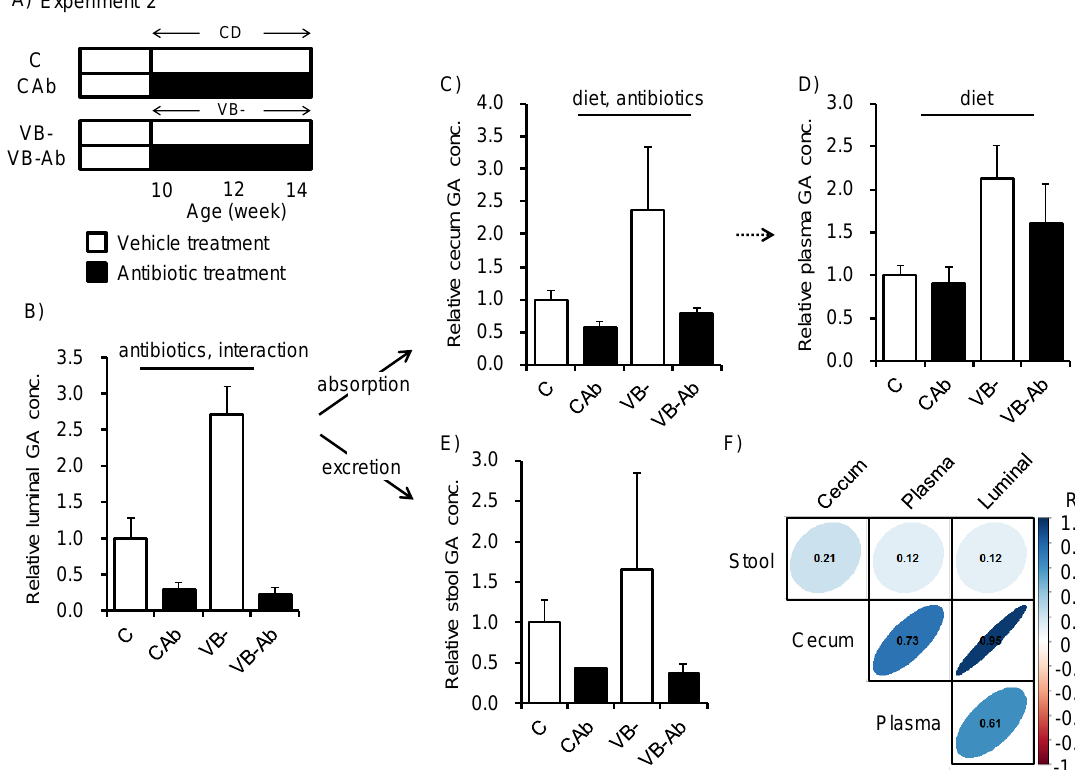
Figure 2. Both the gut microbiota and host accumulated glycolate in mice fed the VB- diet. ( A ) Study design for Experiment 2. Mice were fed the control diet or VB- diet for 4 weeks with or without treatment with four different antibiotics (150 mg/mouse/day penicillin V, ampicillin, metronidazole, and 75 mg/mouse/day vancomycin solved in distilled water). ( B – E ) Relative concentration of GA in ( B ) luminal content, ( C ) cecum, ( D ) plasma, and ( E ) stool among the four groups ( n = 3–4). Two-way ANOVA was used to determine the effect of diet, antibiotics, and the interaction of the two. p < 0.05. ( F ) Spearman’s rank correlation coefficient used to describe correlation between luminal GA concentration and that in cecum, plasma, and stool had values of 0.95, 0.61, and 0.12, respectively.